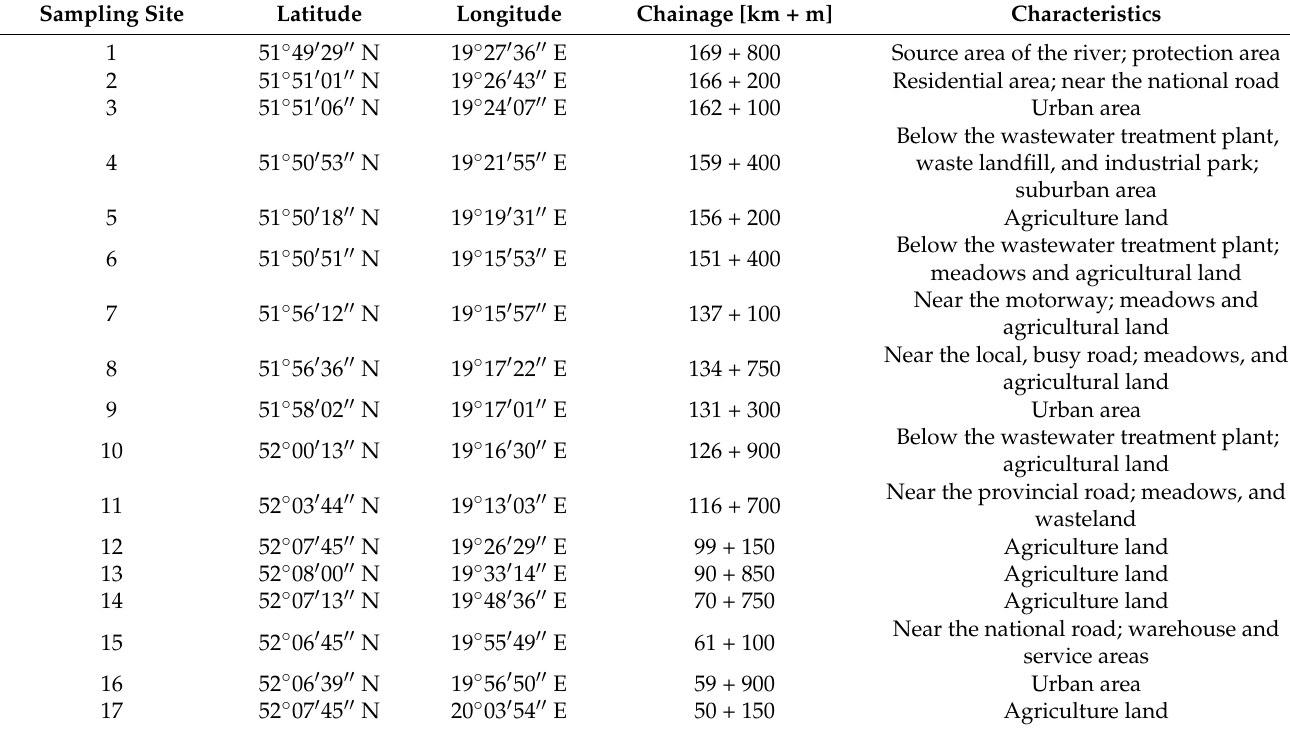
Table 1. Description of sampling